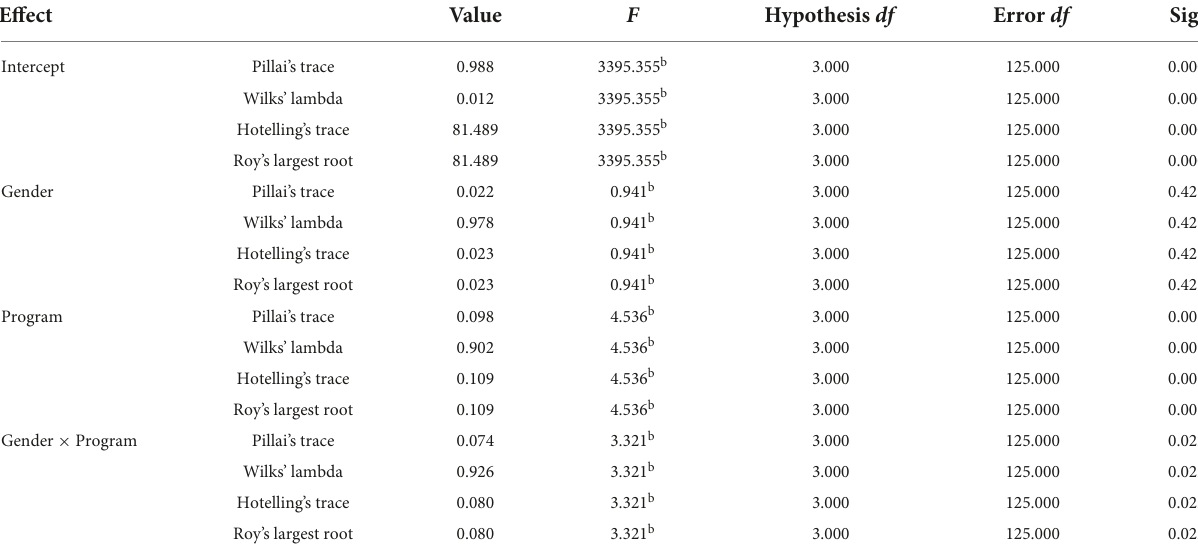
TABLE 2 Multivariate test.